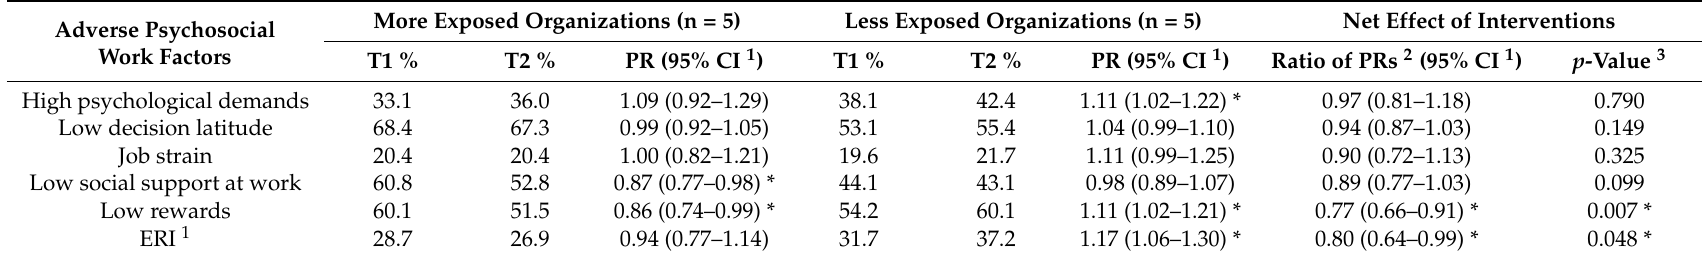
Table 3. Prevalence (%) and prevalence ratios (PR) of adverse psychosocial work factors according to organizations’ exposure to interventions in the Management Practices area of the QHES 1 , before (T1) and after (T2) QHES 1